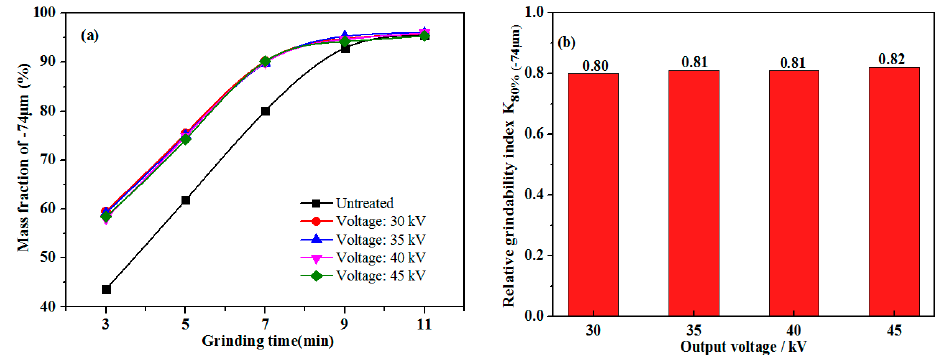
Figure 6. The effect of the output voltage on ( a ) mass fraction and ( b ) grindability